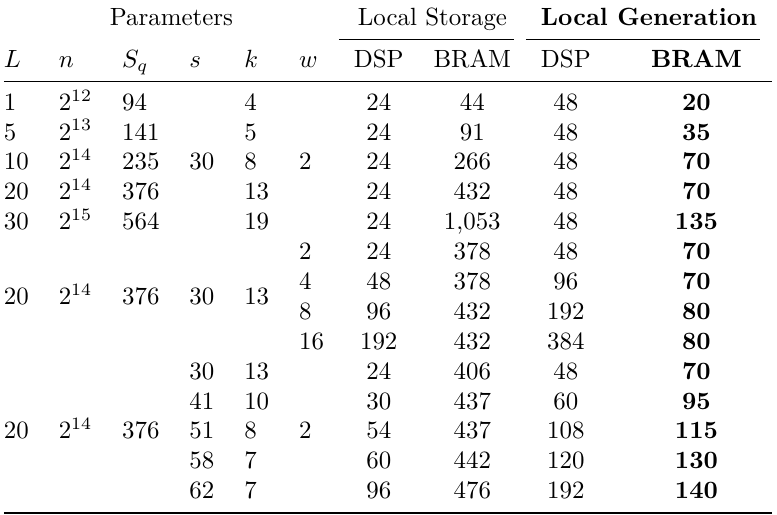
Table 5: Resource utilization for local storage and local generation of twiddle factors. Parameters Local